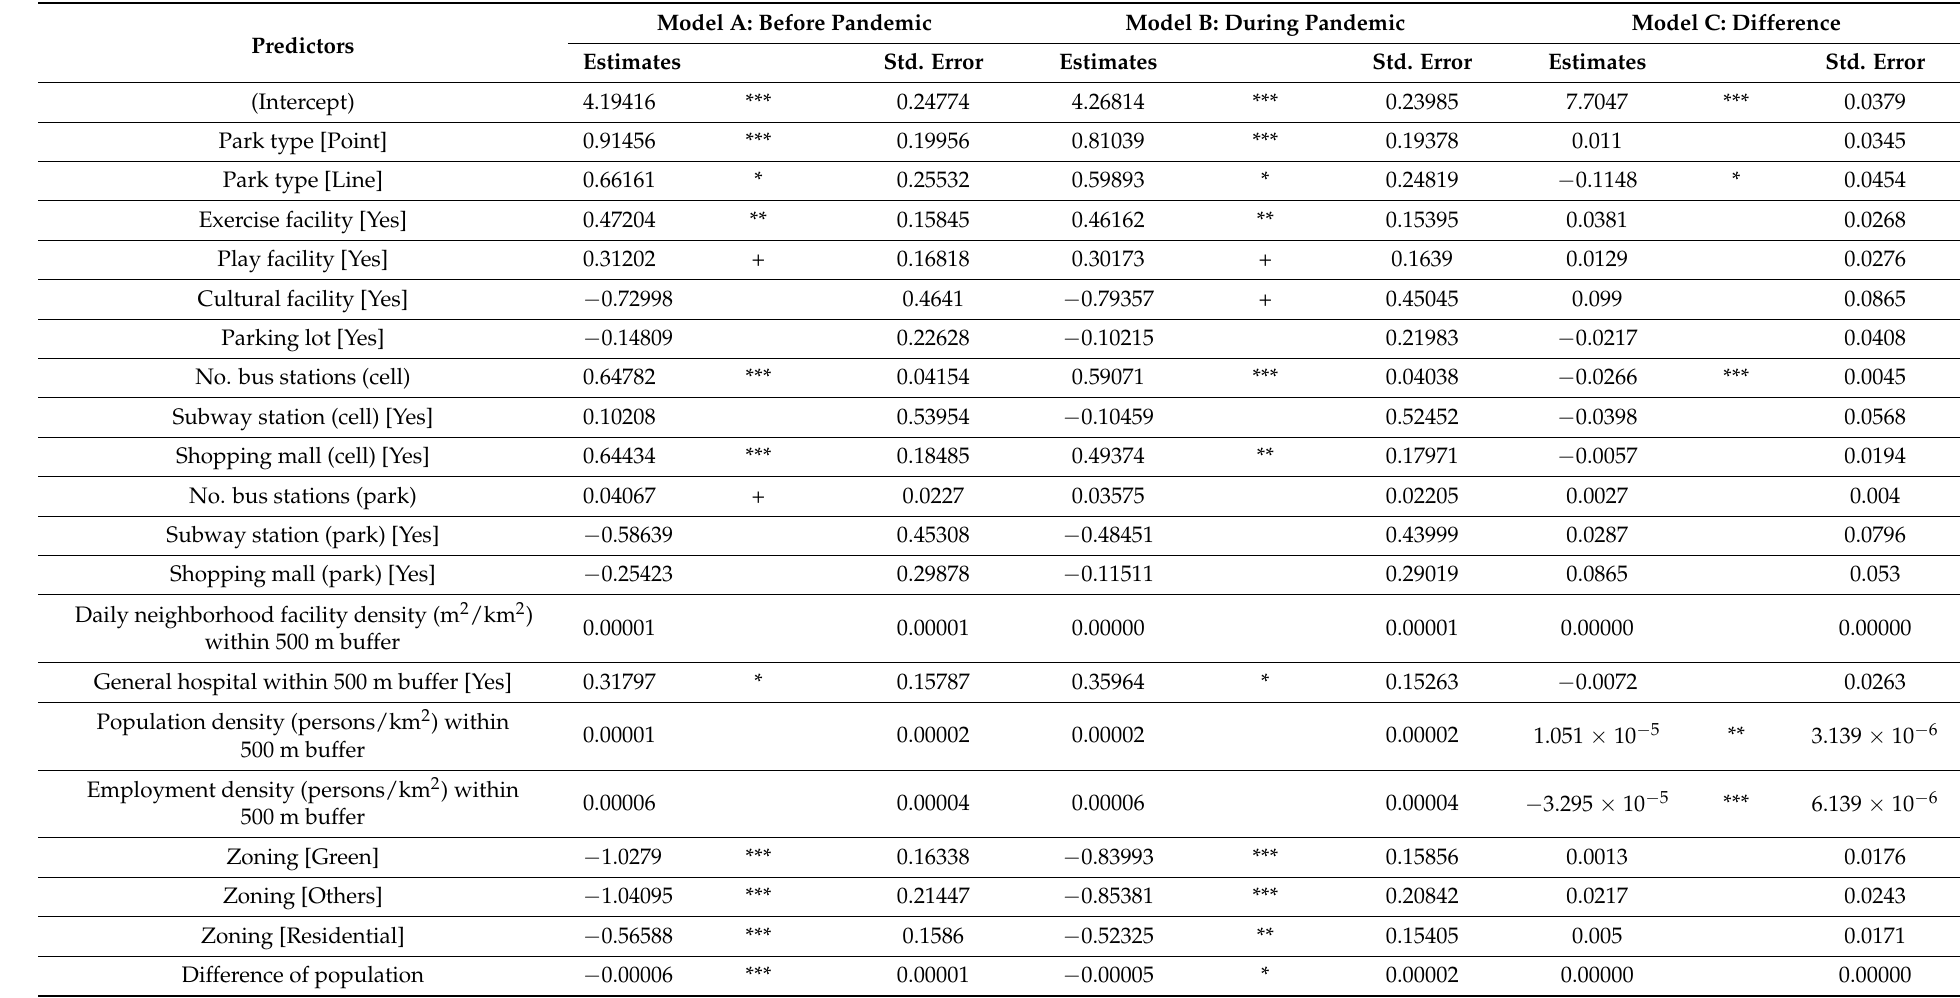
Table 2. Analysis results on regression